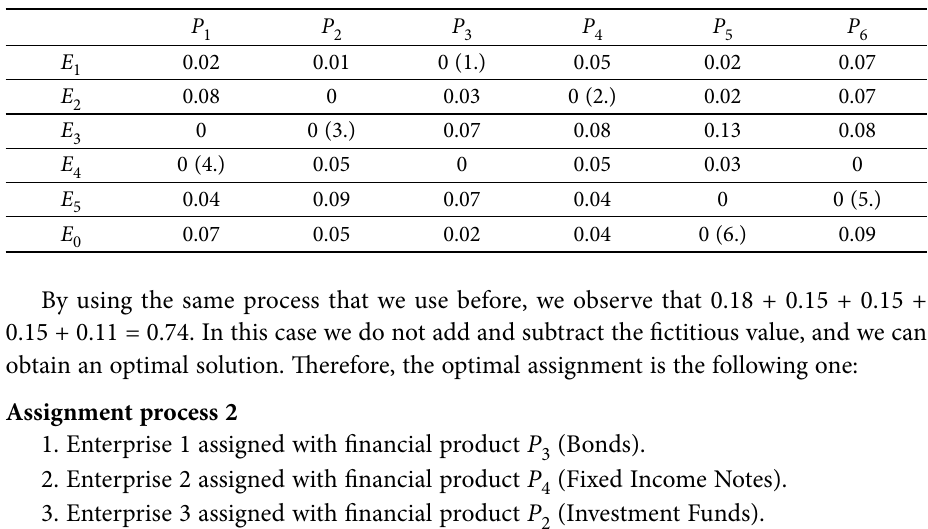
Table 8. Aggregated results with the OWAD